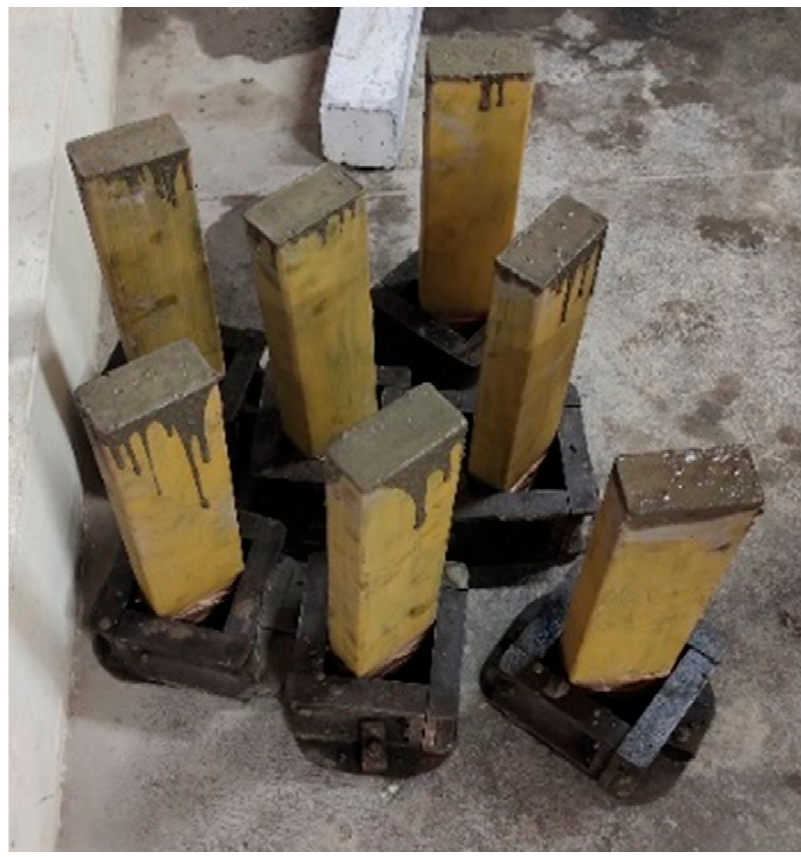
Figure 3. Freshly cast CFST. A metal cap was screwed to the top and bottom surfaces of the column after the column was hardened for 28 days. Then, at mid-height on either side, strain gauges were mounted. To gauge the column’s axial shortening, a deflectometer was placed at its base. Two additional deflectometers were placed at mid-height to measure the longitudinal and lateral deflections on either side of the cross-section. The specimen’s axial load was applied using a hydraulic pump. The behaviour of the column specimen was recorded using dial gauges. Figure 4 depicts the setup for the experiment testing on columns. A 5 kN increment was used to apply the load on the column. Until failure, the strain and deflection were recorded for each increase in